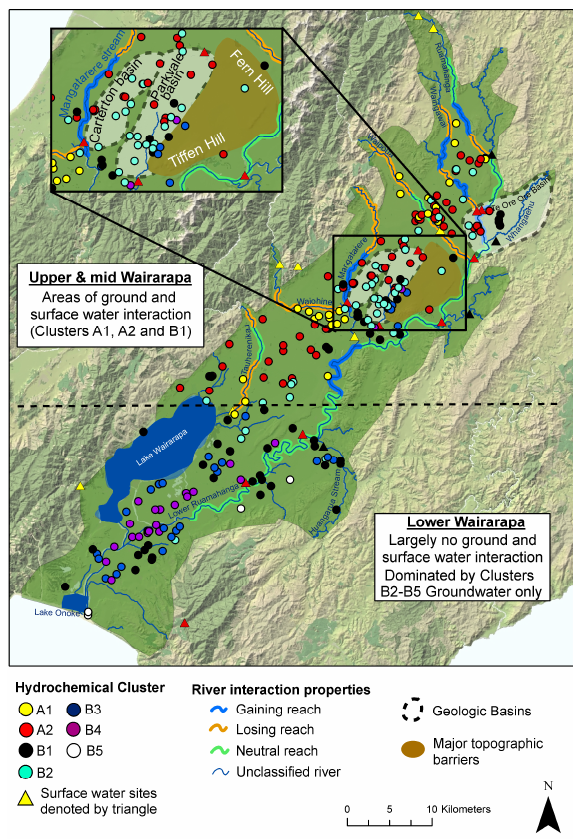
Fig. 11. Spatial distribution of groundwater and surface water monitoring sites assigned to seven hydrochemical clusters in the Wairarapa Valley, New Zealand. Distribution is shown in regards to pre-determined river interacting properties; losing, gaining and neutral (Jones and Gyopari, 2006).